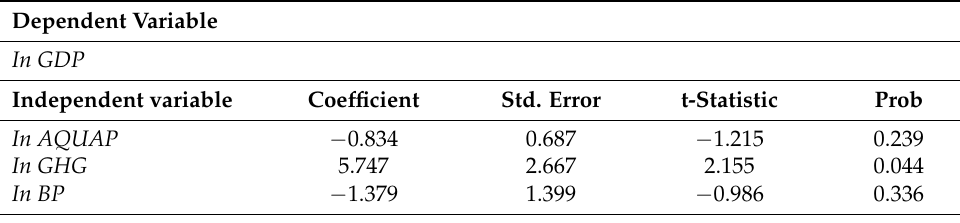
Table 4. Long-run relationship and error correction model regression for GDP model.